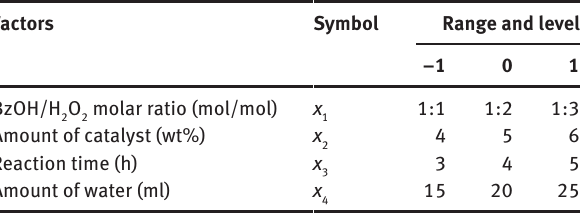
Table 2: List of symbols for various experimental variables and corresponding coded levels and ranges adopted in the experimental designs.